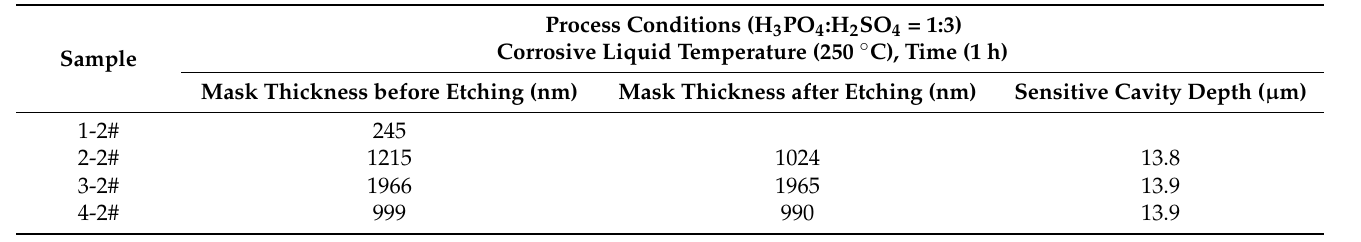
Table 3. Process results at 250 ◦ C.